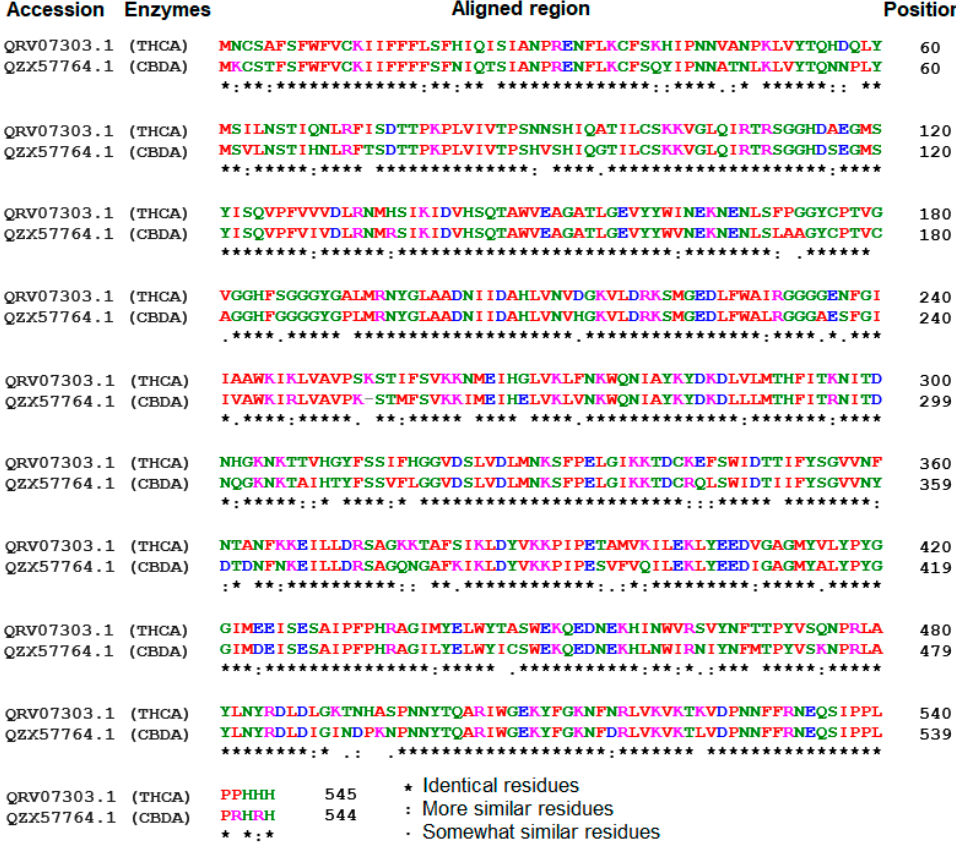
Figure 3. Sequence alignment among tetrahydrocannabinolic acid (THCA) and Cannabidiolic acid (CBDA) synthases using the Clustal Omega alignment server.